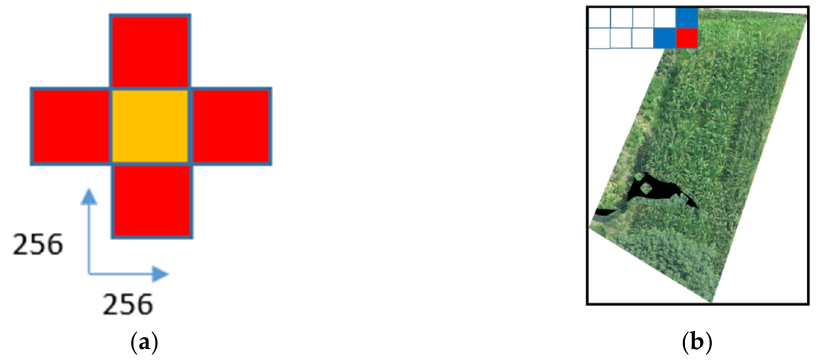
Figure 7. The sample using a cross-over strategy. ( a ) The cross-quadrant for sampling selection; ( b ) the processing for the field block.